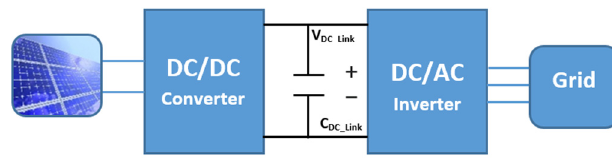
Figure 14. Microgrid topology.